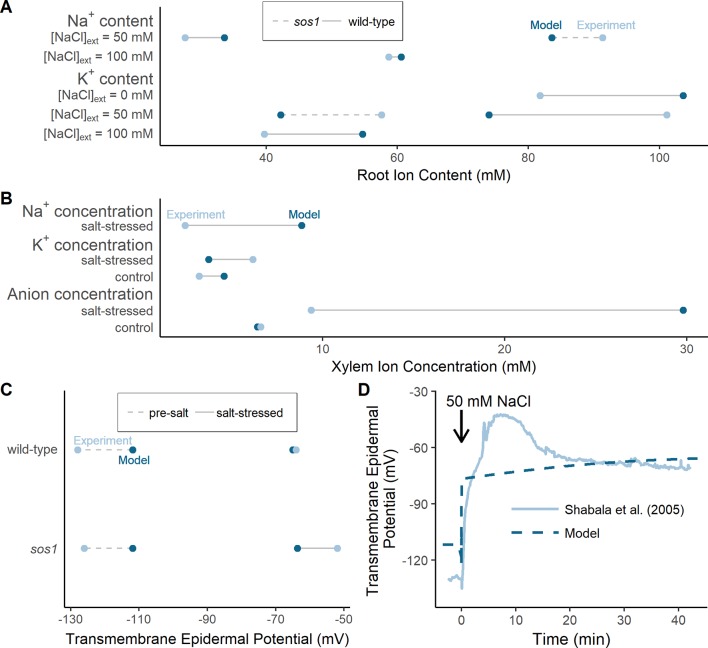
The optimized model simulations are comparable to a wide range of experimental measurements. (A) Comparison of optimized model (dark blue circles) and experimental (light blue circles) root Na+ and K+ content measurements, for external NaCl concentrations ranging from 0 to 100 mM, for wild-type plants (solid lines) and sos1 mutants (dashed lines). (B) Comparison of optimized model (dark blue circles) and experimental (light blue circles) xylem concentrations of Na+, K+, and anions, in the presence and absence of 50 mM NaCl. (C) Comparison of optimized model (dark blue circles) and experimental (light blue circles) pre-salt (dashed lines) and salt-stressed (solid lines) transmembrane epidermal potentials. (D) Comparison of optimized model (dashed dark blue line) and experimental (solid light blue line) changes in transmembrane epidermal potential over time. All simulations were conducted using the parameters in
Tables S1
 and
S2
. Experimental data was obtained from Shabala et al. (2005), Hall et al. (2006), Davenport et al. (2007) and Mason et al. (2010). Comparisons with: Davenport et al. (2007) were conducted with 50 mM NaCl, 11.9 mM KCl, 0.5 mM Ca2+, and a pH of 5.5 in the external medium; Hall et al. (2006) were conducted with 50 mM NaCl, 2 mM KCl, 2 mM Ca2+, and a pH of 4.4 in the external medium; Mason et al. (2010) were conducted with 100 mM NaCl, 7.5 mM KCl, 0.8 mM Ca2+, and a pH of 5.7 in the external medium; Shabala et al. (2005) were conducted with 50 mM NaCl, 0.5 mM KCl, 0.1 mM Ca2+, and a pH of 5.5 in the external medium.